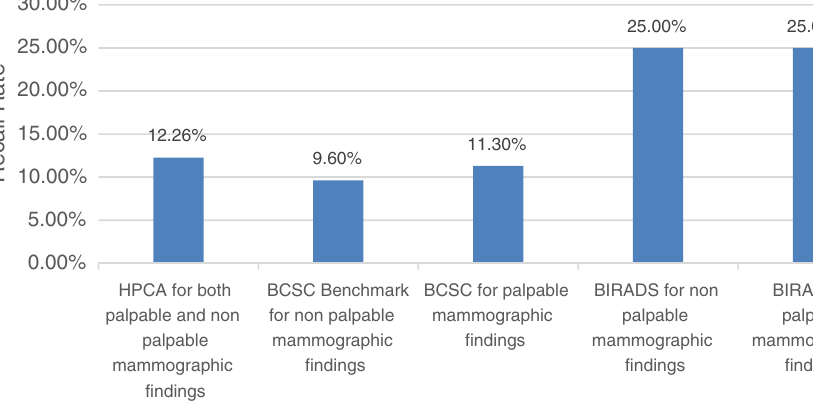
Fig. 1 Percentages of abnormal interpretation/recall rate